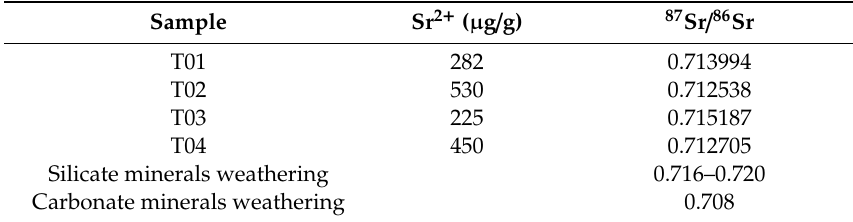
Table 2. Strontium isotope and concentrations of lake-bottom sediments and